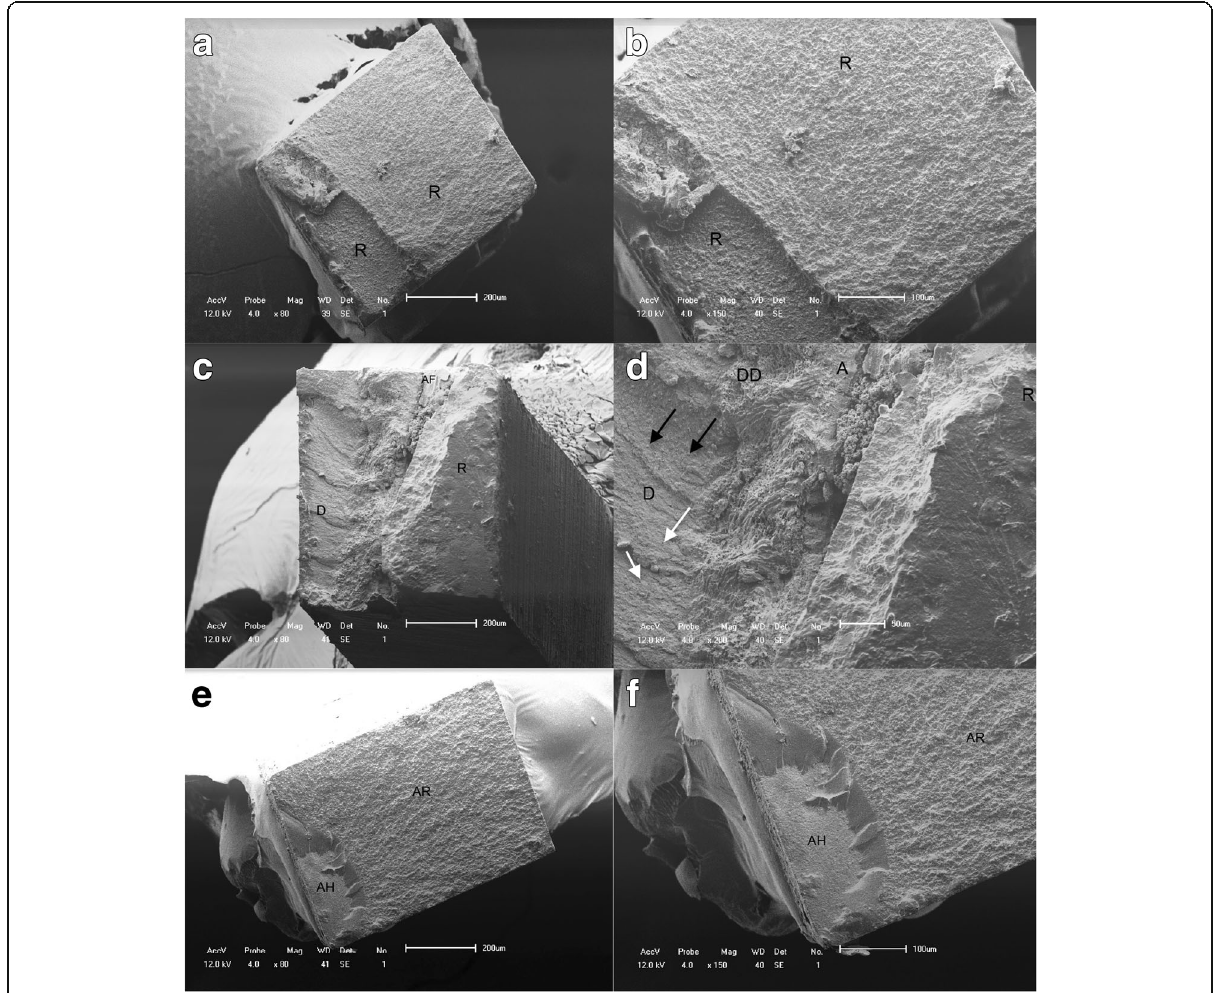
Fig. 5 Representative scanning electron micrographs of the fractured specimens. a and b Scanning electron photomicrographs of the cohesive failure of resin composite. c and d Mixed fractures. c Part of the fracture occurred inside the adhesive layer, probably just under the hybrid layer, because parts of the dentinal tubules are exposed (D-adhesive fracture) and parts are covered by the adhesive layer (A-cohesive fracture) with resin on top of a small adhesive area (R). d A mixed fracture shows deep dentin (DD), a thin adhesive film (AF) on dentin, and the presence of opened dentin tubules (white arrows) and fractured resin tags still attached (black arrows). e and f Adhesive failure: cohesive failure in the bonding resin and/or in the hybrid layer. e The fracture that occurred both between the adhesive layer and resin (AR) and under the hybrid layer